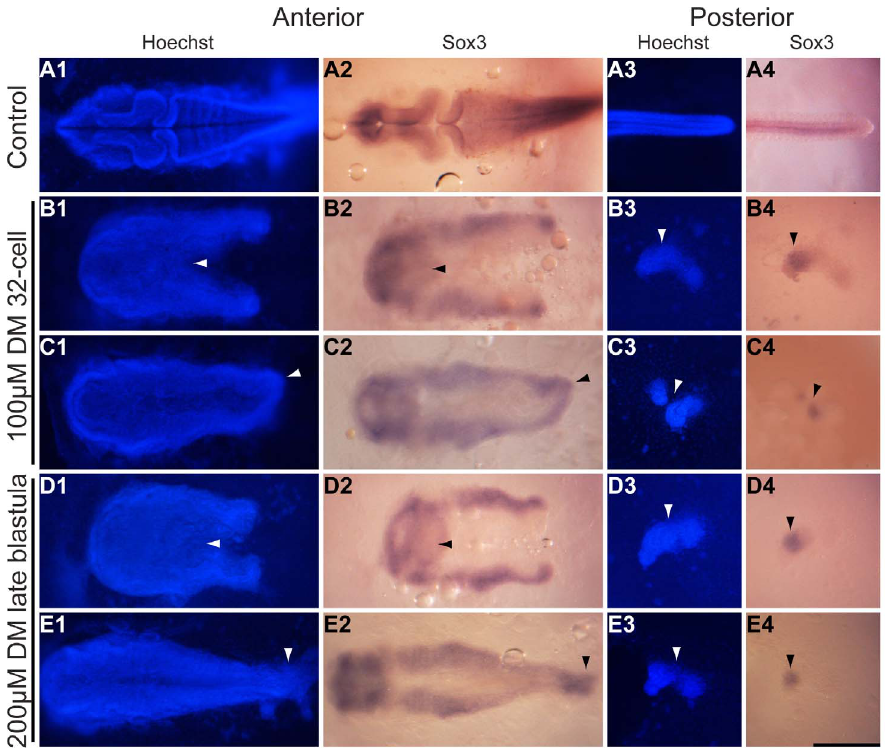
Figure 3. The neural tube is separated in embryos of the splitbody phenotype. K. marmoratus embryos were exposed to 100 m M dorsomorphin (DM) at the 32-cell stage ( B, C ), and 200 m M DM at the late blastula stage ( D , E ) of development. These embryos were then fixed 3 days post-fertilization and used for in situ hybridization using a sox3 probe (stains all neural tissue) ( A–E2, A–E4 ) and Hoechst staining (a blue fluorescent DNA stain) ( A–E1, A–E3 ) in order to examine body contour and split neural tube ( A–E1 , 2 ), and the nature of the posterior isolated cell lumps or cell islands ( A–E3 , 4 ). A1–4 : Control embryo (n=20/20). B, D : Splitbody individual with an opened end of the body axis and neural tube split ( B1, 2 arrowheads n=19/20, and D1, 2 arrowheads n=12/20). Splitbody individuals with a closed end, as both strands of the body axis and neural tube join in their most posterior region ( C1, 2 arrowheads n=1/20, and E1, 2 arrowheads n=8/20). All DM embryos presented here generated cell islands ( B-E3 arrowheads) with distinct sox3 positive staining ( B–E4 arrowheads). All images are dorsal views of the embryos. Scale bar: 250 m m.